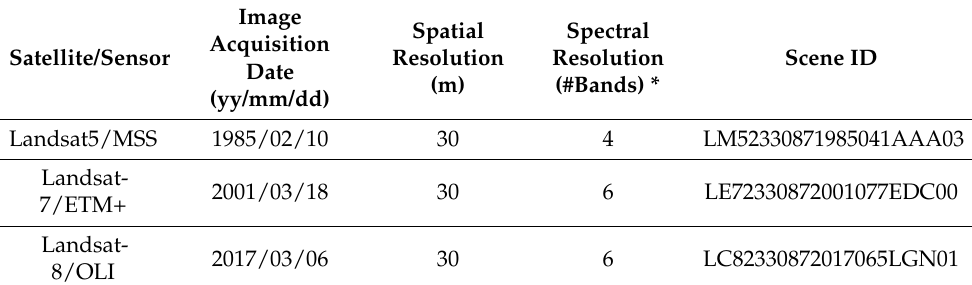
Table 1. Main description of the satellite images used. Source: Authors’ compilation.